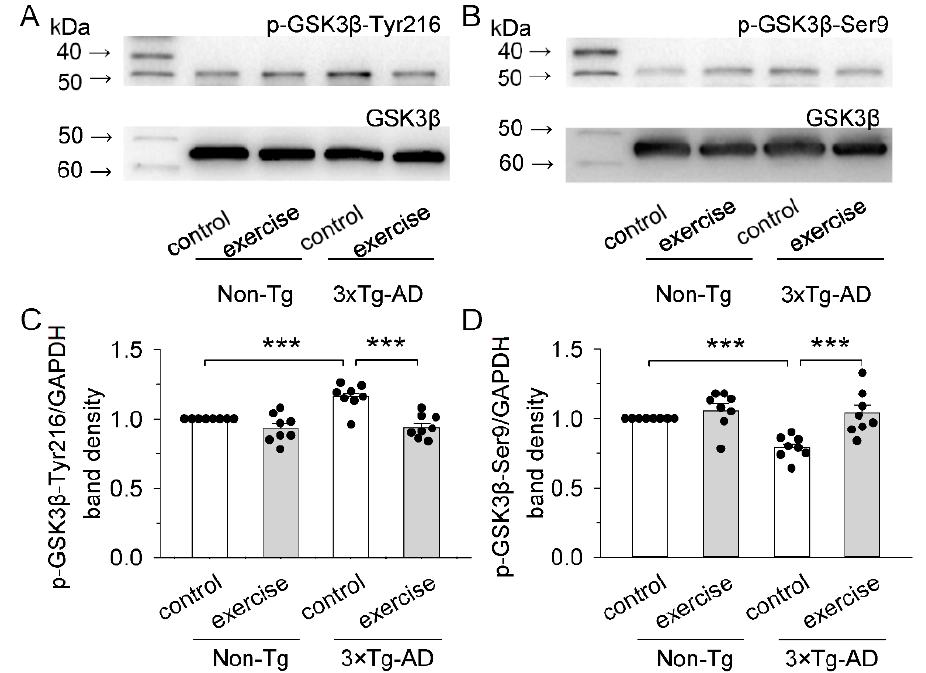
Figure 2. Treadmill exercise inhibited the kinase activity of GSK3 β in 3 × Tg-AD mice. ( A , B ) Repre- sentative western blots for p-GSK3 β -Tyr216 ( A ), p-GSK3 β -Ser9 ( B ), and GSK3 β ( A , B ) of prefrontal cortex homogenates were prepared from these four groups of mice. ( C ) Summarized data showed that p-GSK3 β -Tyr216/GSK3 β in the prefrontal cortex were significantly increased in the 3 × Tg-AD mice compared to the non-Tg control group (*** p < 0.001, n = 8-8) and this increase was blocked by treadmill exercise pretreatment (*** p < 0.001, n = 8-8). ( D ) Summarized data showed that p-GSK3 β